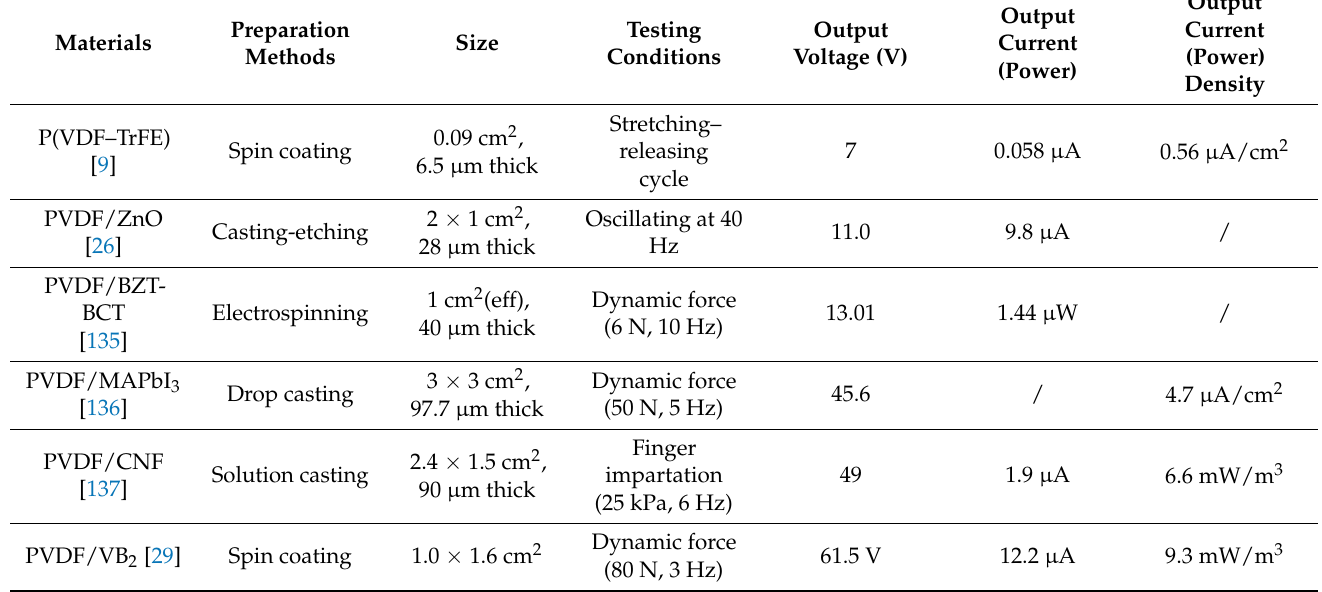
Table 4. Performances of several kinds of PVDF-based piezoelectric